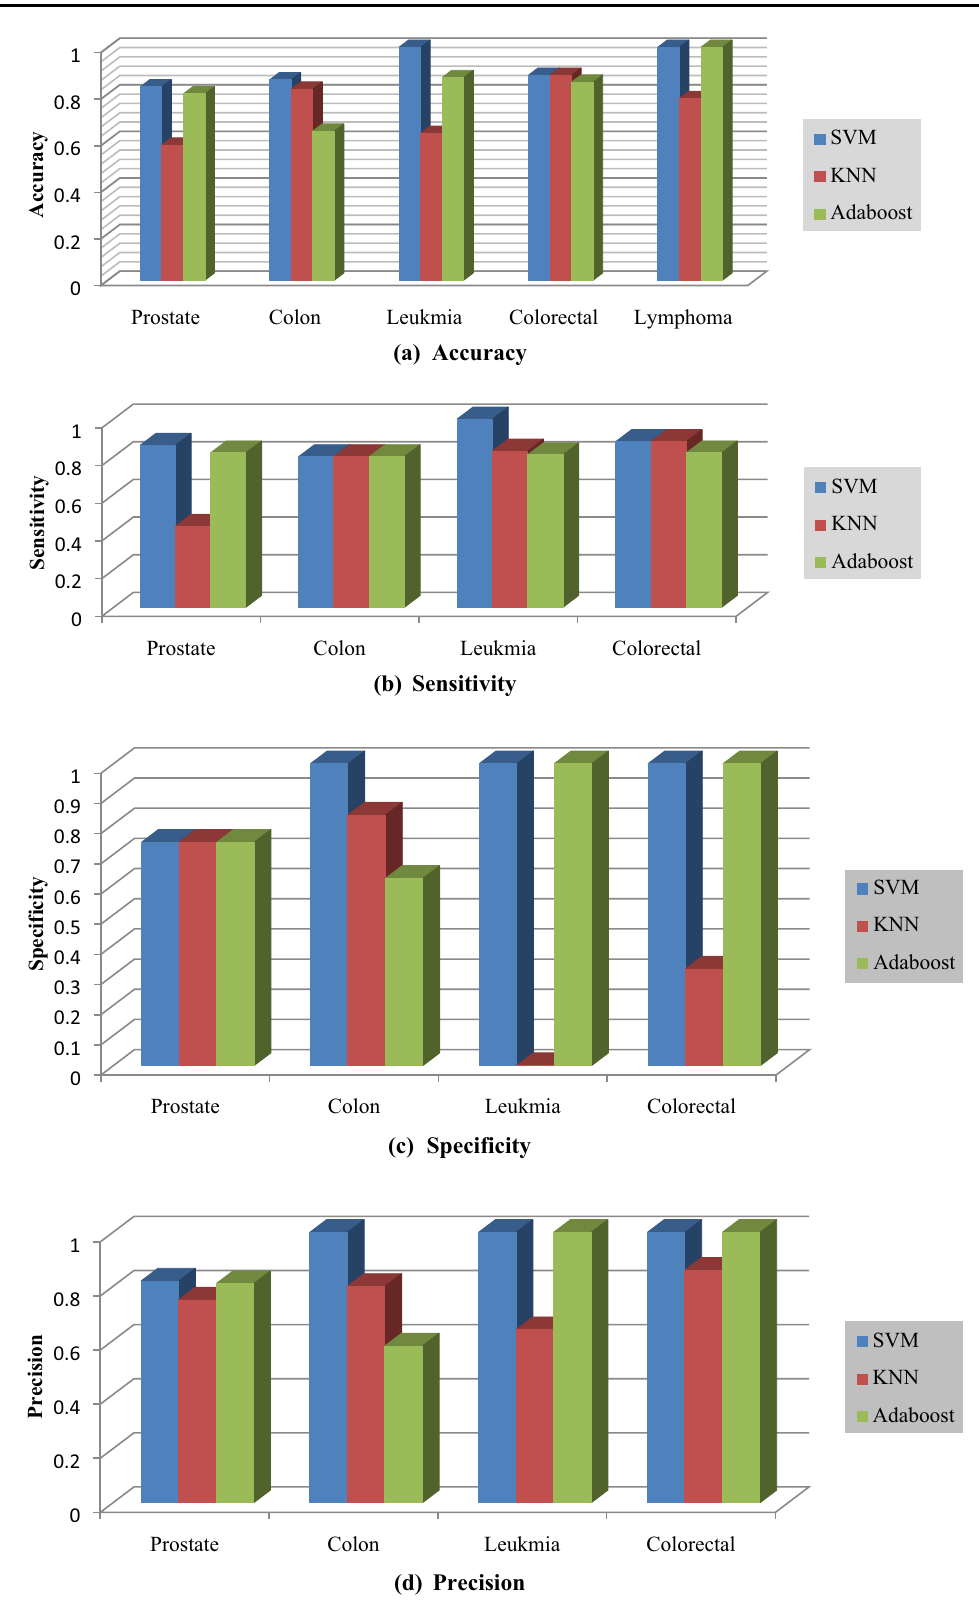
Fig. 3 Comparisons of Accuracy, SN, SP, and Precision of each Data Set under Three